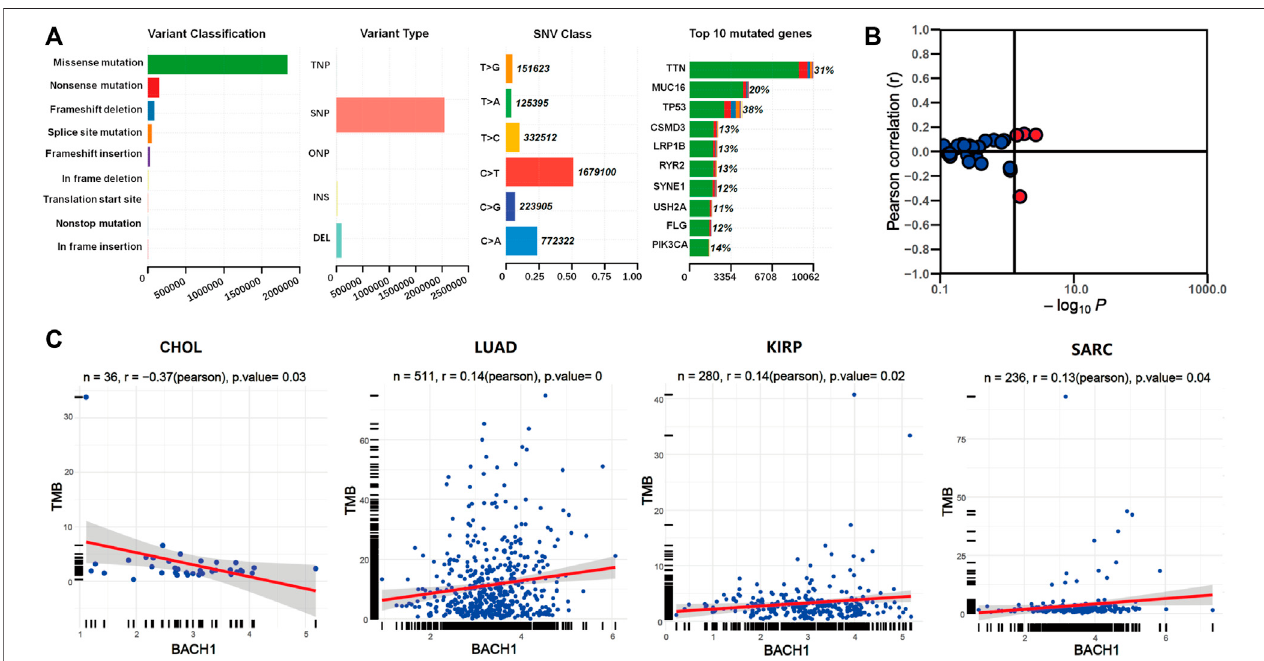
FIGURE4| TherelationshipbetweenBACH1expression andsomaticmutation. (A) Thesomaticmutationdataof33cancerpatients fromtheTCGAdatabase (B) The relationship between BACH1 and TMB (C) Four cancer types in which BACH1 is associated with